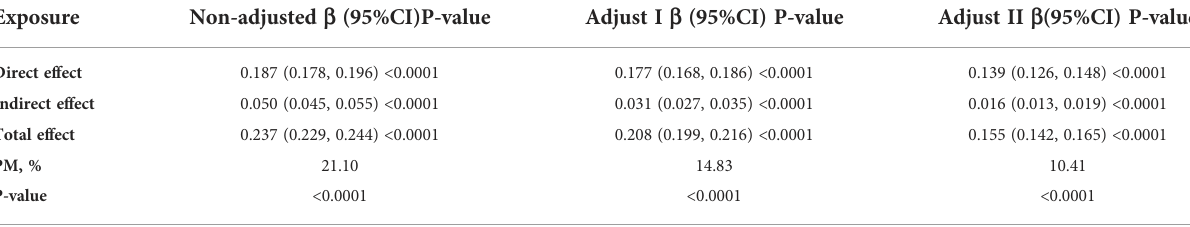
TABLE 7 Mediation analysis of the association between WHtR and the risk of NAFLD mediated by